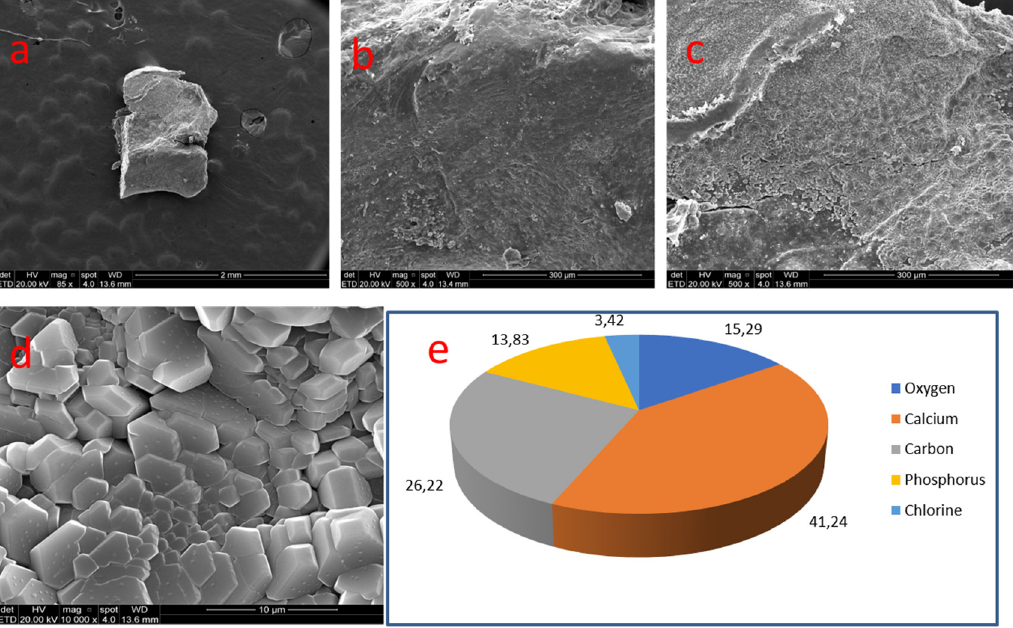
Figure 7. Sample 05: ( a ) Rectangular nodule (SEM, 85×); ( b ) Smooth and compact surface (SEM, 500×); ( c ) surface covered with exogenous substance (SEM, 500×); ( d ) sodium chloride crystals (SEM, 10,000×); ( e ) Results of chemical analysis of the sample with X-ray dispersive energy spectroscopy (EDX).